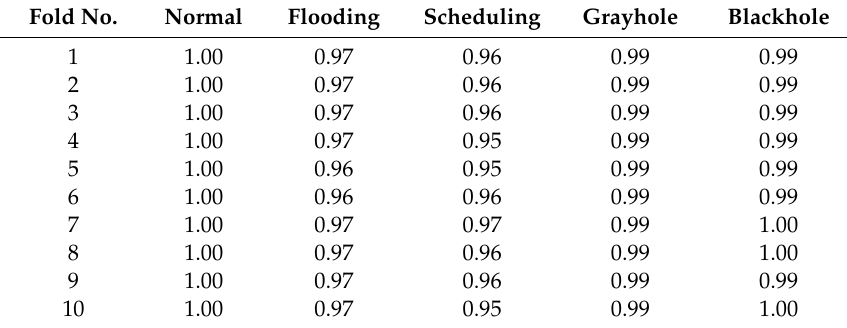
Table 6. F1-score results of the 10 fold cross validation.